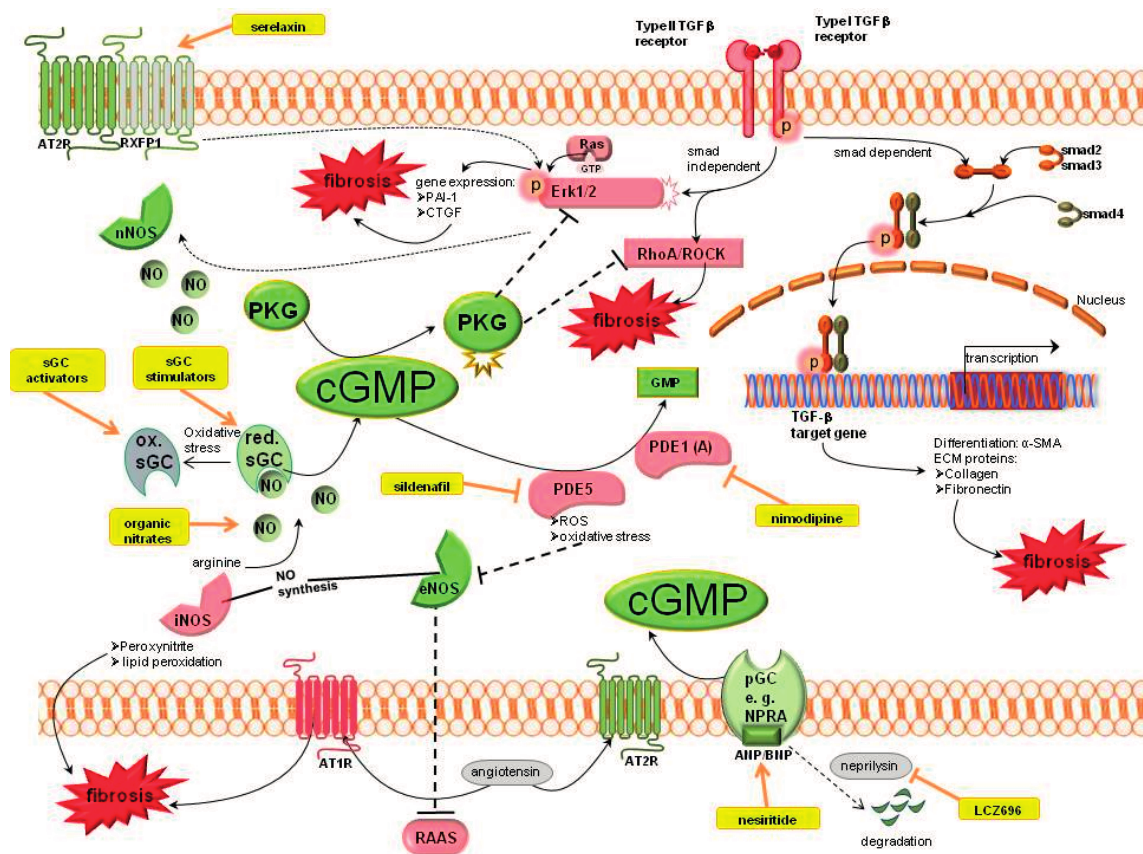
Figure 2. Cyclic guanosine monophosphate signalling pathways in kidney fibrosis including pharmacological treatment options. ANP, atrial natriuretic peptide; AT 1 R, angiotensin II receptor type 1; AT 2 R, angiotensin II receptor type 2; BNP, brain natriuretic peptide; cGMP, cyclic guanosine monophosphate; CNP-c, type natriuretic peptide; CTGF, connective tissue growth factor; ECM, extracellular matrix; eNOS, endothelial NO synthase; ERK1/2, extracellular-signal regulated kinase; GMP, guanosine monophosphate; GTP, guanosine triphosphate; iNOS, inducible NO synthase; nNOS, neuronal NO synthase; NO, nitric oxide; NPRA, natriuretic peptide receptor A; PAI-1, plasminogen activator inhibitor 1; PDE, phosphodiesterase; pGC, particulate guanylyl cyclase; PKG, cGMP dependent protein kinases; RAAS, renin angiotensin aldosterone system; Ras, Rat sarcoma protein, RhoA, particular Rho protein; ROCK, Rho associated protein kinase; ROS, reactive oxygen species; RXFP1, relaxin family peptide receptor 1; sGC, soluble guanylyl cyclase; SMA, smooth muscle actin; smad, small mothers against decapentaplegic protein; TGF β , transforming growth factor β